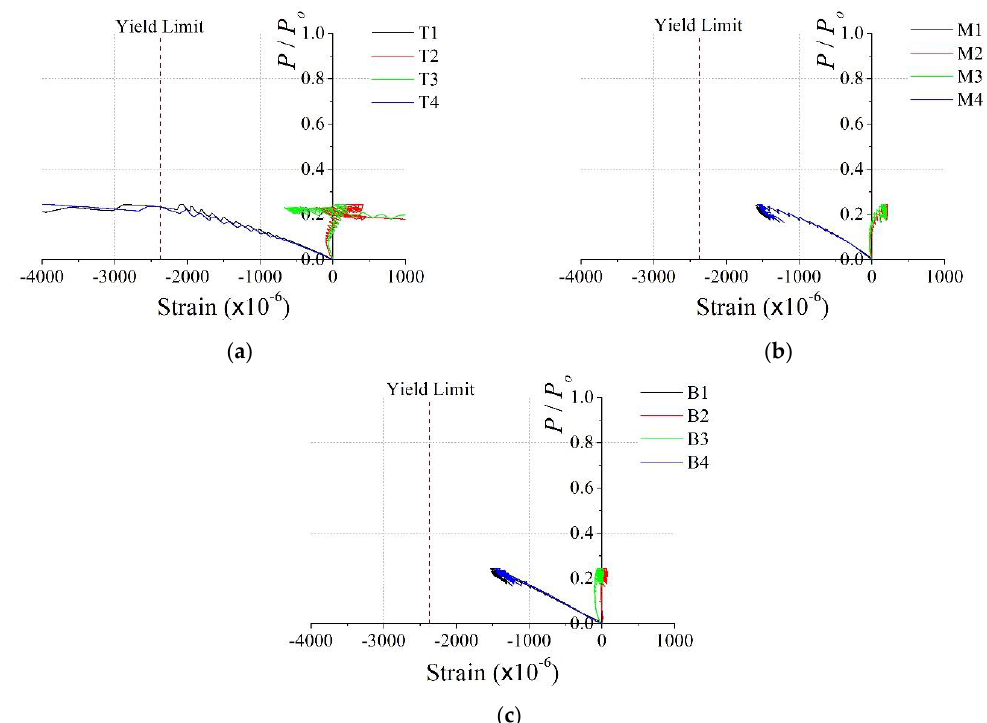
Figure 13. Dimensionless axial load vs. vertical stain for CL25: ( a ) top (T1 – 4); ( b ) middle (M1 – 4); ( c ) bottom (B1 – 4).